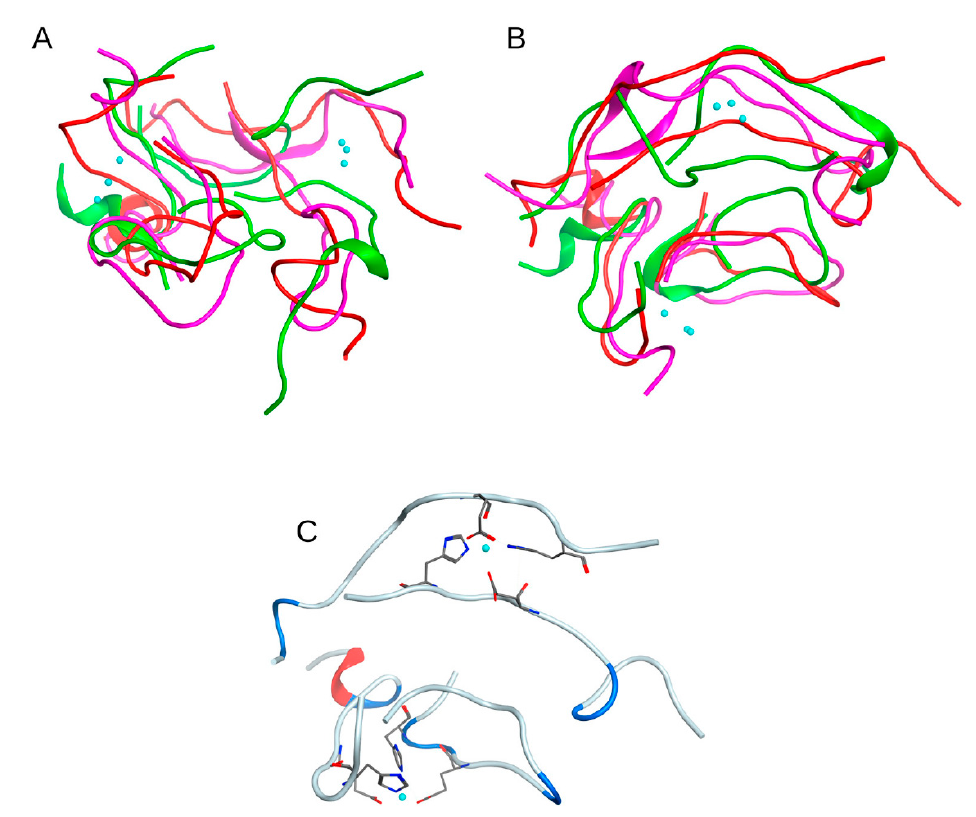
Figure 9. Three conformations with the lowest free energy according to the analysis of energy landscapes from REMD modeling of a complex of four A β 16 molecules with two zinc ions in the coordination centers of A β 16 dimers. ( A , B ) represent different views of the superposition of the three complex conformations. For clarity, each complex structure formed by four A β 16 molecules is highlighted in the same color. Zinc ions are shown in blue. ( C ) shows one of the three conformations. Zinc coordinating side chains are shown.